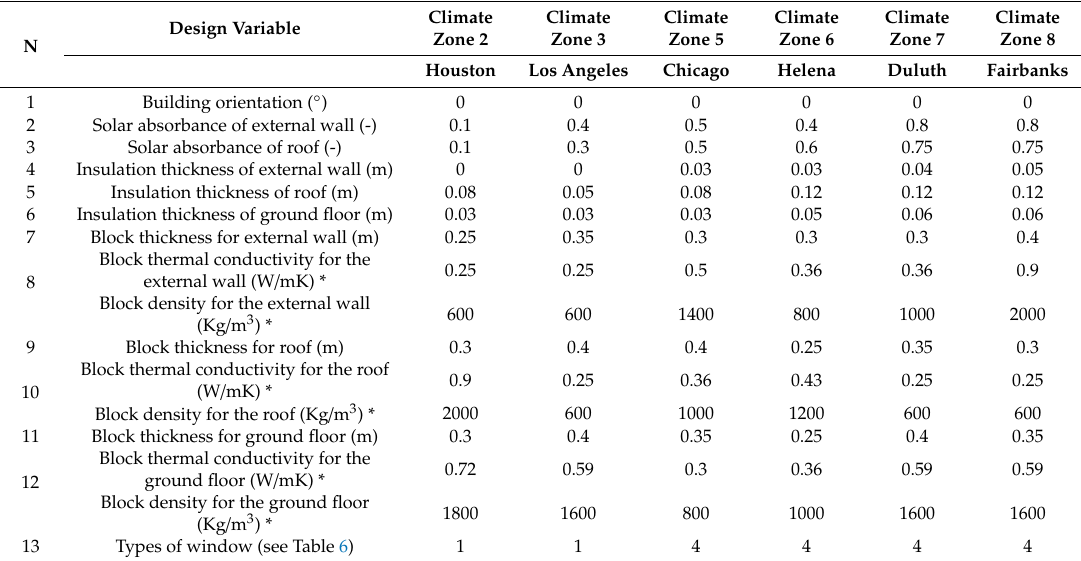
Table 10. Design parameters of reference buildings in various cities of the United States.